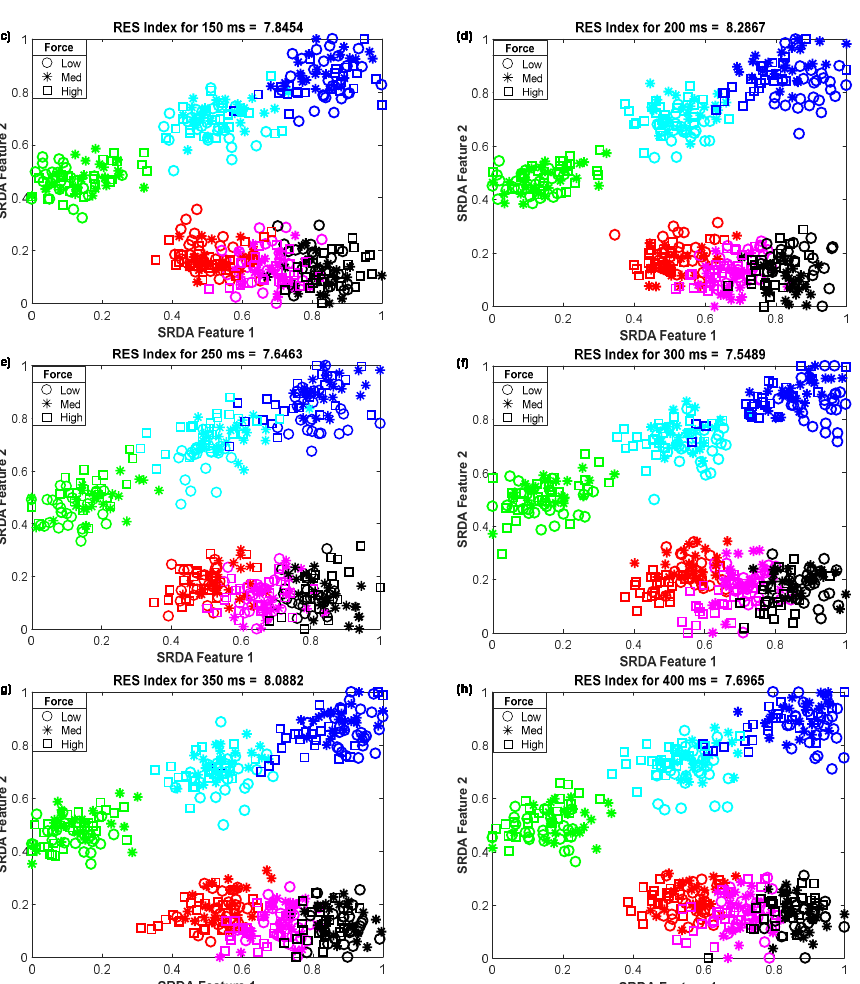
Figure 5. The impact of window length on clustering performance, where ( a – h ) stand for window lengths of 50 ms, 100 ms, 150 ms, 200 ms, 250 ms, 300 ms, 350 ms, and 400 ms, respectively.